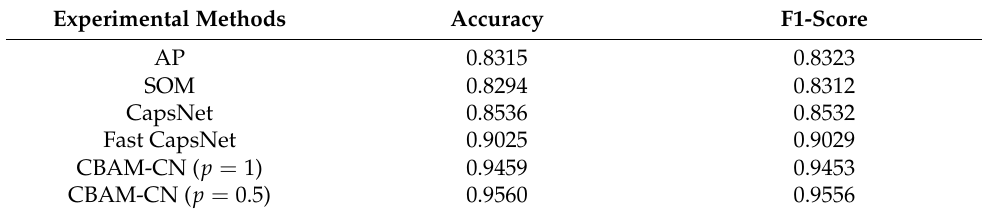
Table 4. Classification results of feature images in the test